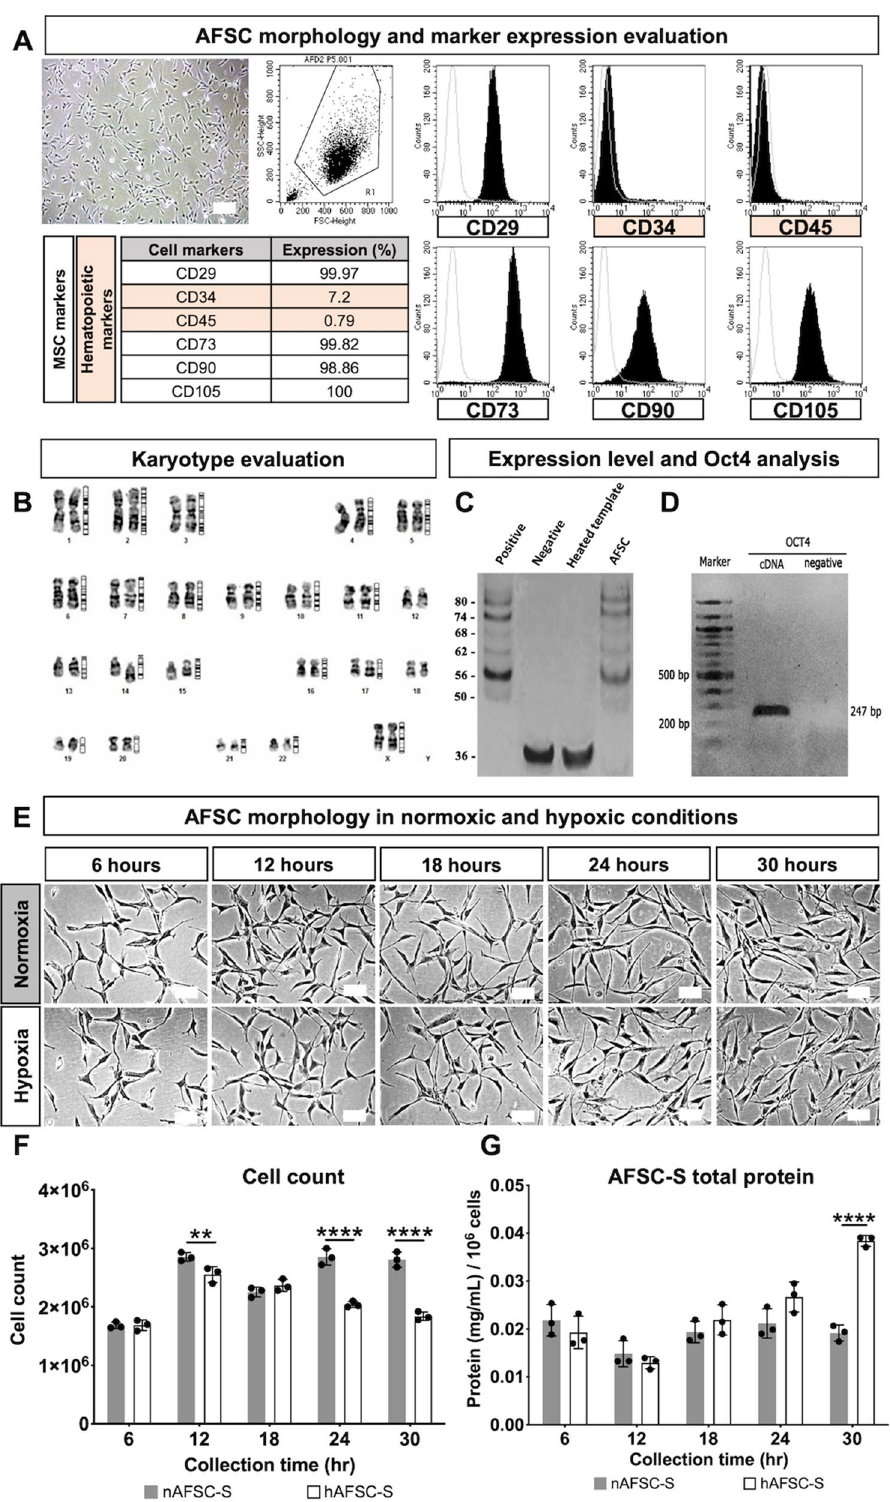
Figure 1. Human amniotic fluid stem cells and amniotic fluid stem cell secretome evaluation. ( A ) Representative image of amniotic fluid stem cells (AFSC) exhibiting fibroblastic morphology and flowcytometric quantification of cell markers. ( B ) Karyotypic analysis. ( C ) Telomerase activity evaluation. ( D ) Oct-4 evaluation. ( E ) Representative images of cell morphology of amniotic fluid stem cells cultured in 21% O 2 (Normoxia) and 1% O 2 (Hypoxia) conditions for 6 to 30 h. ( F ) Total count of AFSC. ( G ) Total protein quantification of AFSC secretome (AFSC-S) collected at 6 to 30 h from normoxic (nAFSC-S) and hypoxic (hAFSC-S) culture conditions. Scale bar 100 µm. Data are expressed as means ± SD. n = 3. ** p < 0.01, **** p < 0.0001 by two-way ANOVA followed by Tukey’s post hoc